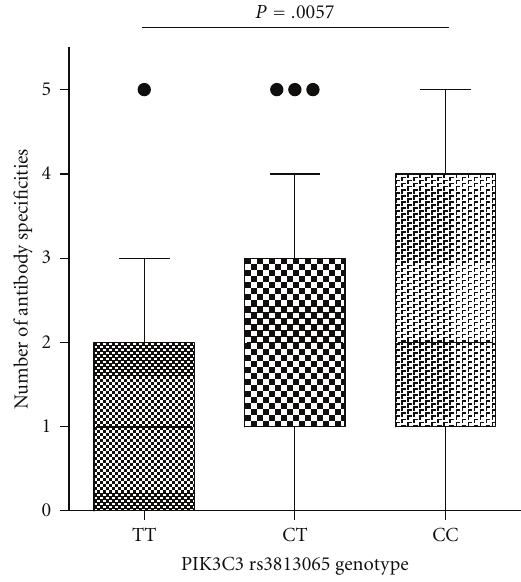
Figure 2: Distribution of the number of di ff erent autoanti- body specificities in African-American SLE patients stratified by rs3813065 genotype. no. of specificities = the sum of the number of positive test results for anti-Ro, anti-La, anti-Sm, anti-RNP, and anti-dsDNA for a given subject (thus every subject is assigned a number 0 through 5). The horizontal line in the middle of the box indicates the median, boundaries of the boxes indicate the interquartile range, and the error bars show the 10th and 90th percentile, respectively. The P value for the Kruskall-Wallis test is